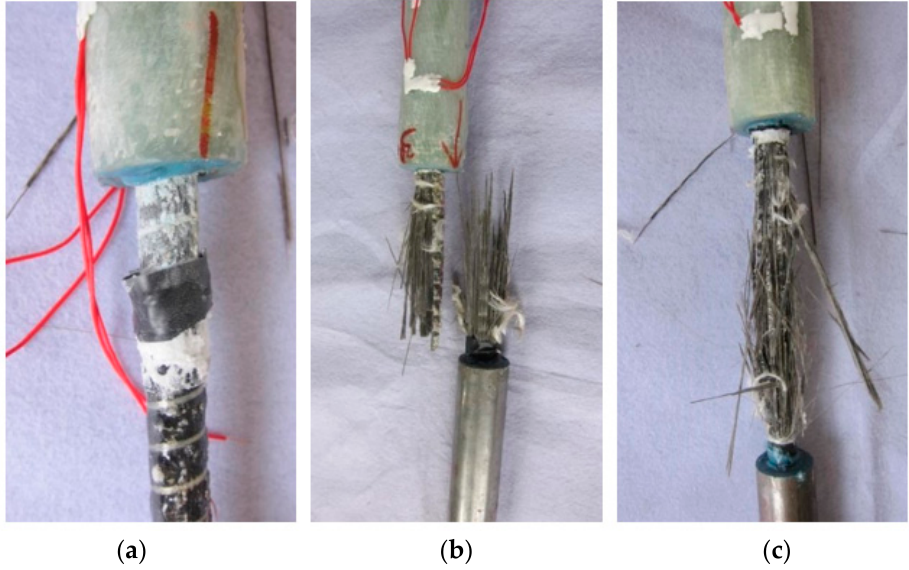
Figure 12. Typical tensile failure modes: ( a ) BFRP bar pullout (S-230-1); ( b ) BFRP bar rupture (S-253-1); and ( c) BFRP bar rupture (S-276-1).